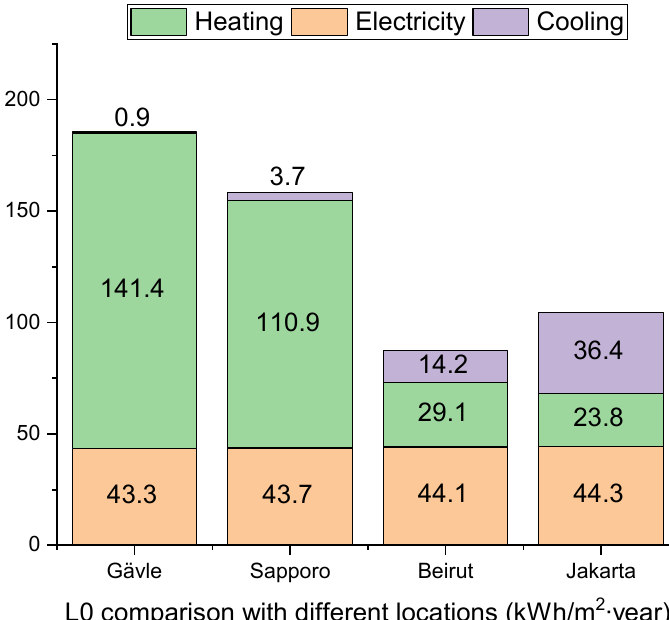
Figure 15. Gävle—Delivered energy profile L0–L4.